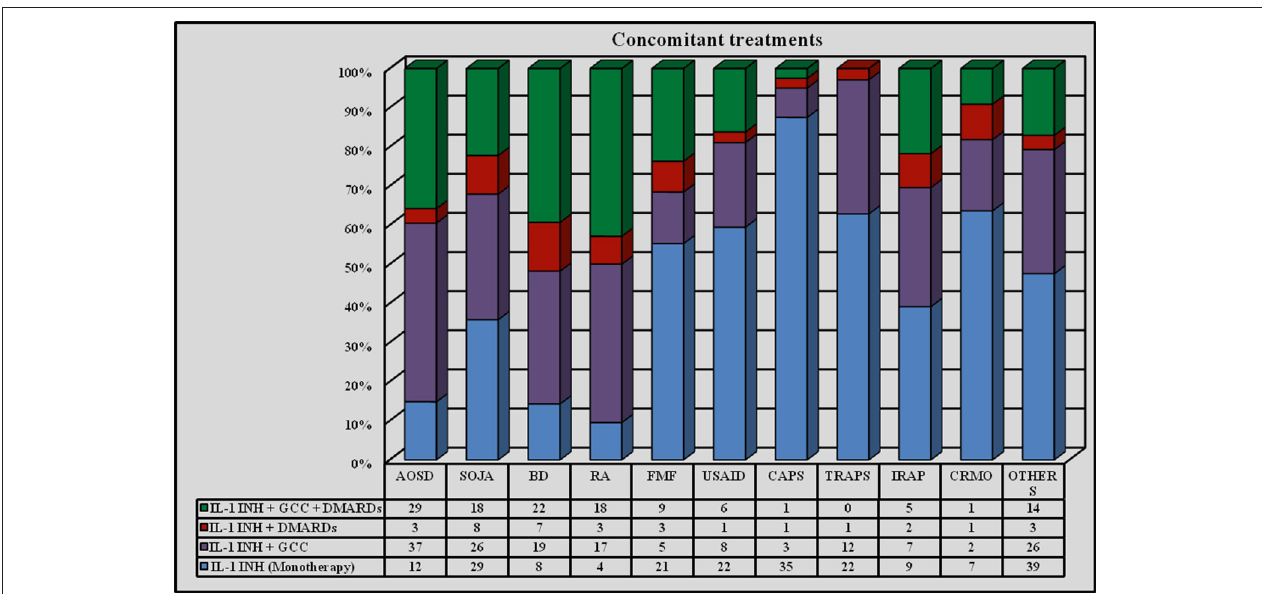
FIGURE 3 | Use of concomitant therapies during IL-1 inhibition distinguishing by different indications. AOSD, Adult Onset Still’s Disease; BD, Behçet’s Disease; CAPS, Cryopyrin-Associated Periodic Syndrome; CRMO, Chronic Recurrent Multifocal Osteomyelitis; FMF, Familial Mediterranean Fever; IRAP, Idiopathic Recurrent Acute Pericarditis; RA, Rheumatoid Arthritis; SOJA, Systemic Onset Juvenile Idiopathic Arthritis; TRAPS, Tumor Necrosis Factor Receptor-Associated Periodic Syndrome; USAID, Undifferentiated Systemic AutoInflammatory Disease.